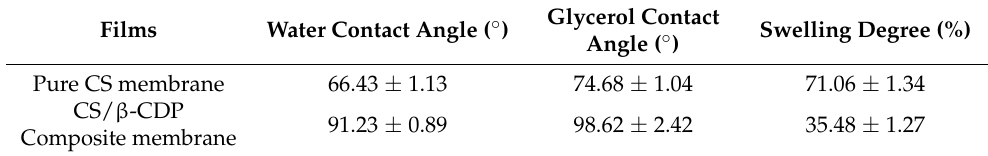
Table 5. Results of contact angle and swelling